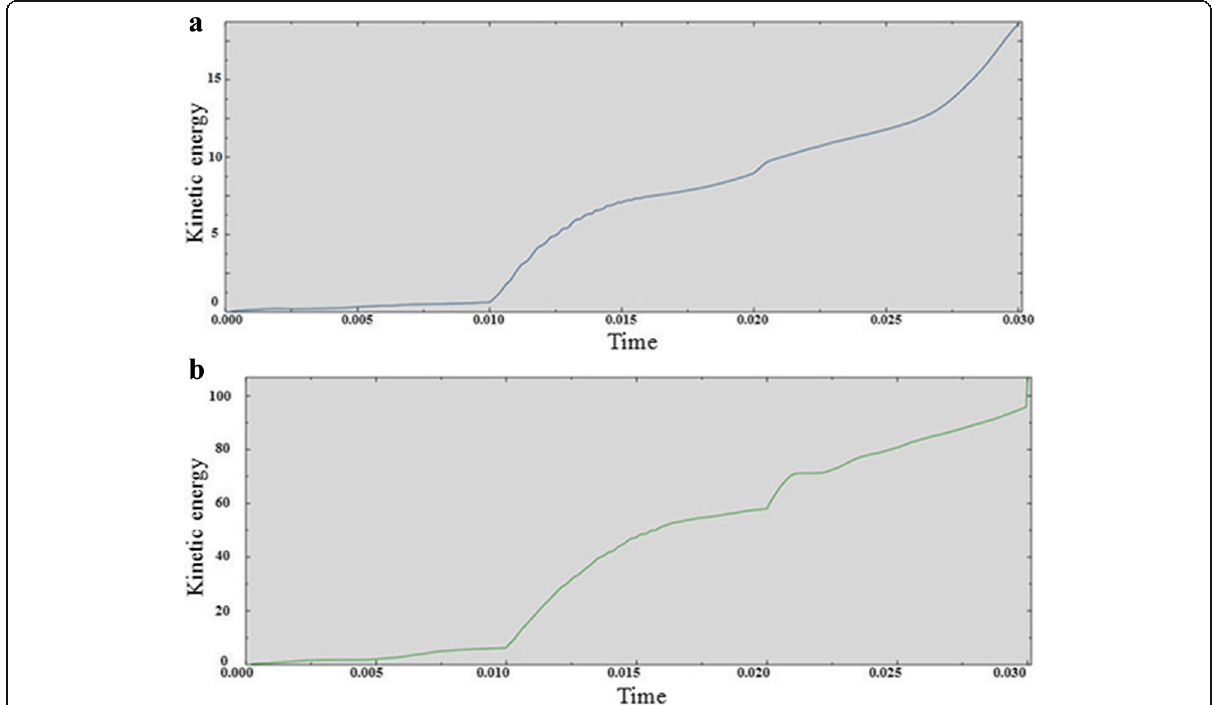
Fig. 7 a The kinetic energy graph of the work piece during forming and without taking into account the springback. b The internal energy graph during forming and regardless of the